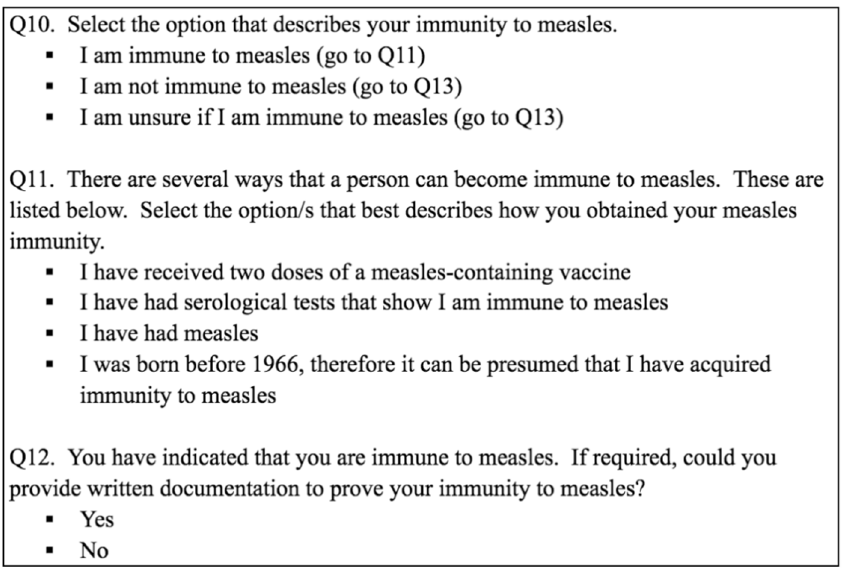
Figure 1. Use of categories to define measles immunity.